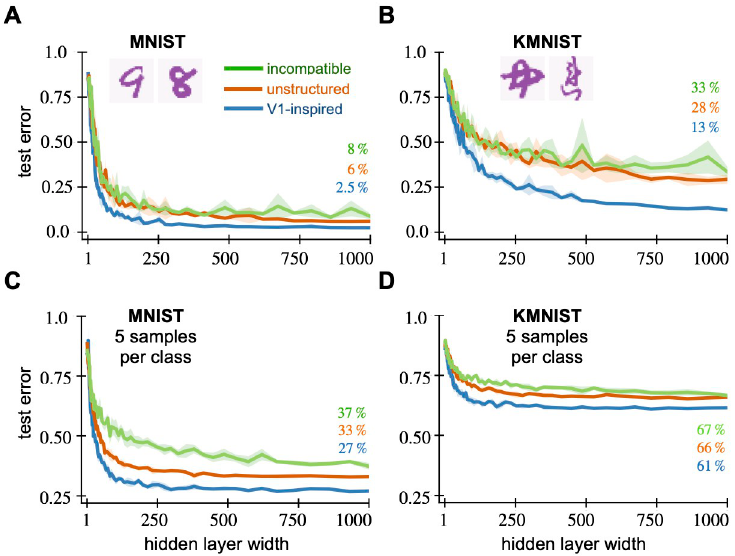
Fig 7. Random V1 weights enable learning with fewer neurons and fewer examples on digit classification tasks. We show the average test error of random feature networks with both V1 and classical white-noise weights against the number of neurons in their hidden layer. For every hidden layer width, we generate five random networks and average their test error. The solid lines show the average test error while the shaded regions represent the standard error across five generations of the random network. The top row shows the network’s test error on (A) MNIST and (B) KMNIST tasks. When their covariance parameters are tuned properly, V1-inspired networks achieve lower error using fewer hidden neurons on both tasks. The network performance deteriorates when the weights are incompatible to the task. (C) MNIST and (D) KMNIST with 5 samples per class. The V1 network still achieves lower error on these fewshot tasks when the parameters are tuned